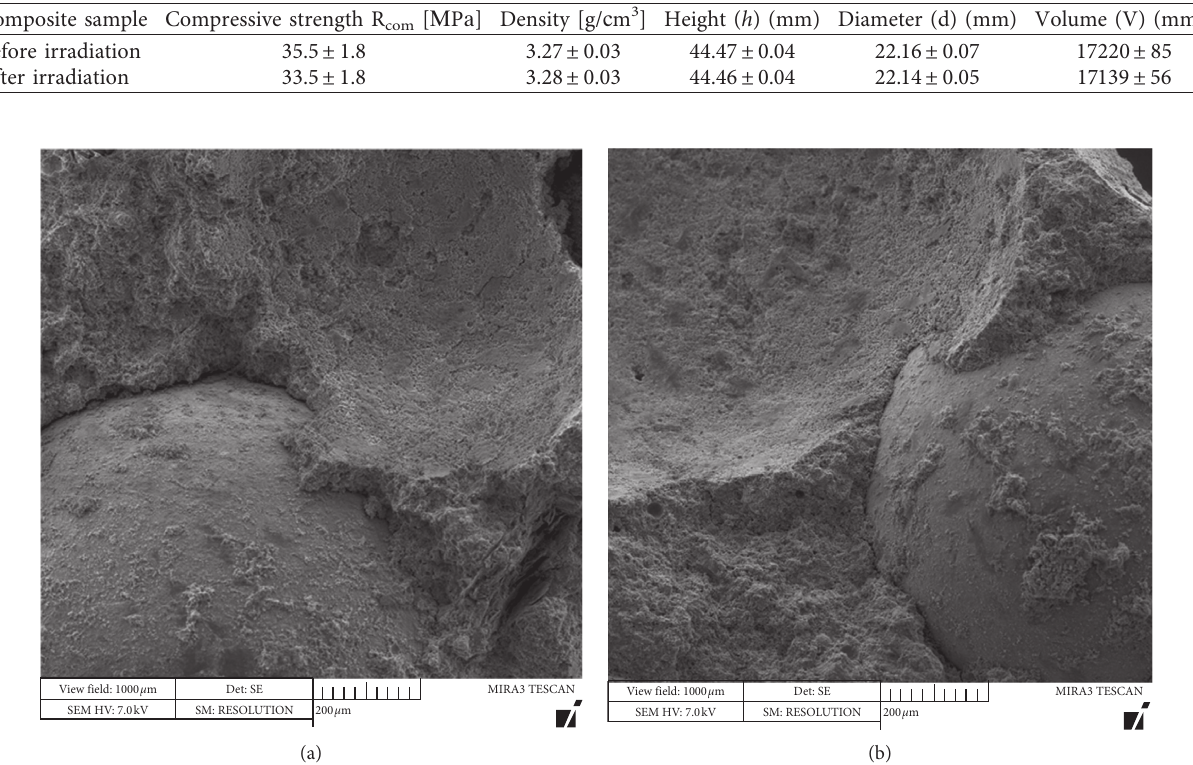
Figure 5: Appearance of composite material samples based on a modified shot of titanium hydride and Portland cement before (a) and after (b) irradiation with fast neutrons at a fluence of 1.9 ∙ 10 19 neutrons/cm. 2 . Table 2: Change in geometric and physicomechanical properties of irradiated composite samples.